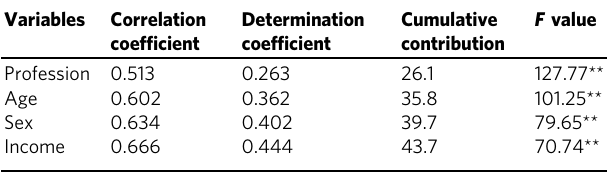
Table 11 The relative contribution of the studied independent variables in explaining the total variance in the degree of change in the cultural identity of the respondents.